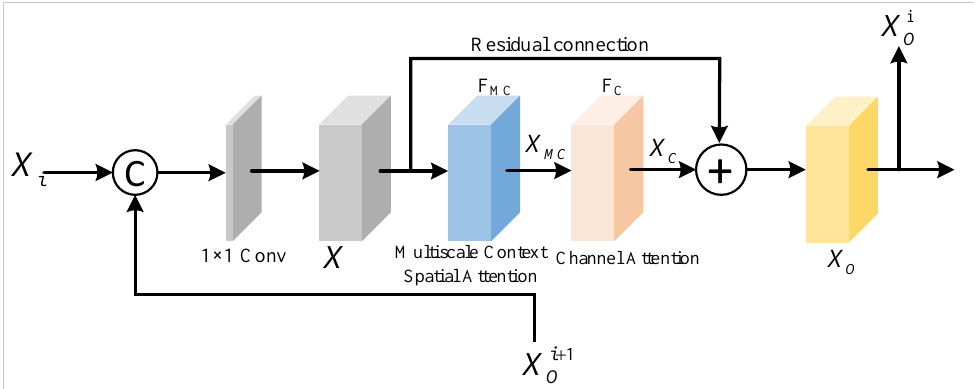
Figure 3. Detailed structure of multiscale context attention